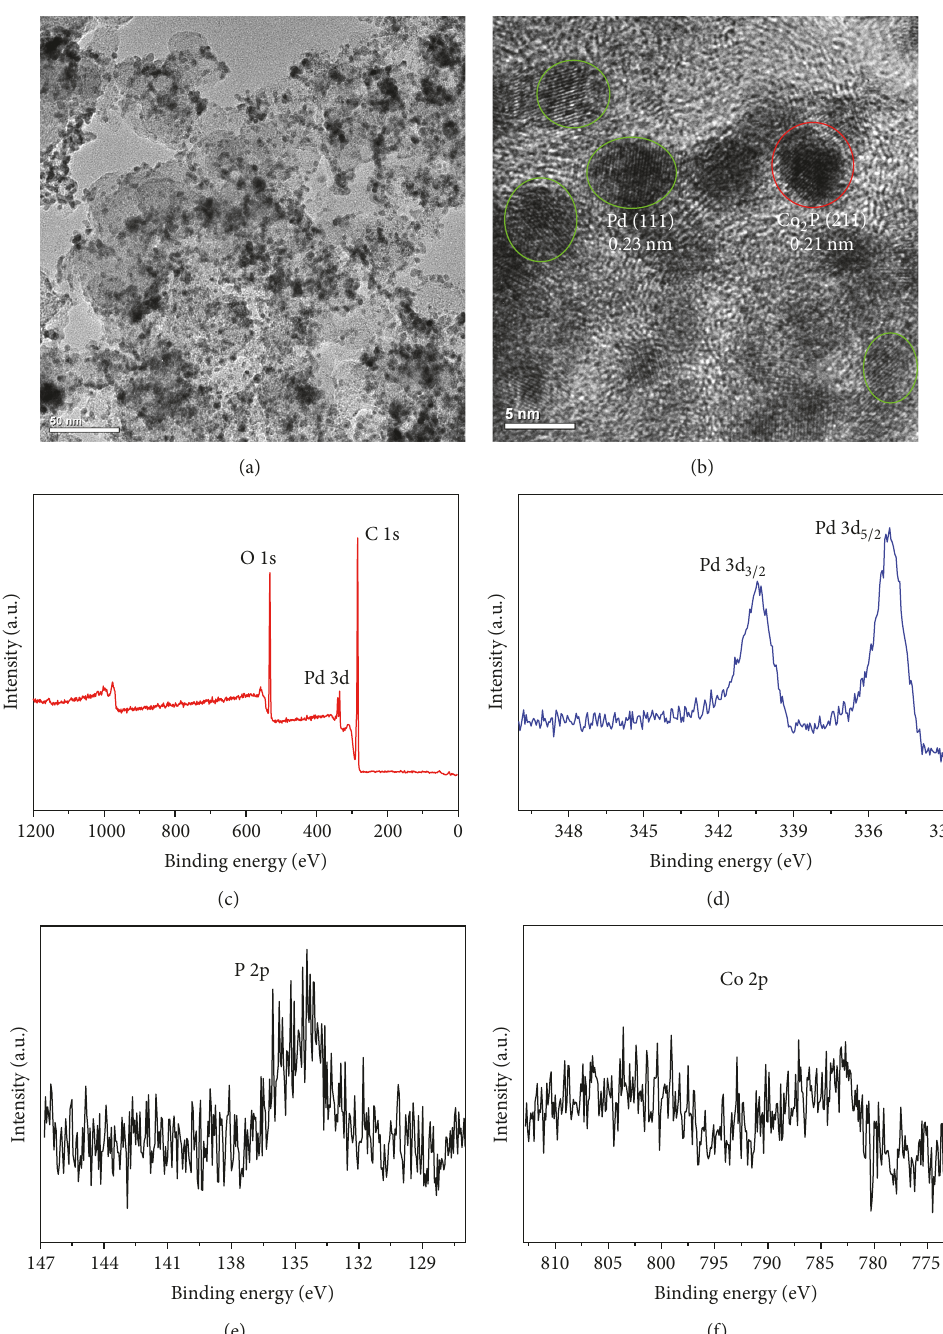
Figure 4: The TEM (a), HRTEM (b), and the survey, Pd 3d, P 2p, and Co 2p XPS spectra (c)–(f) of the C/Co 2 P/Pd composites.